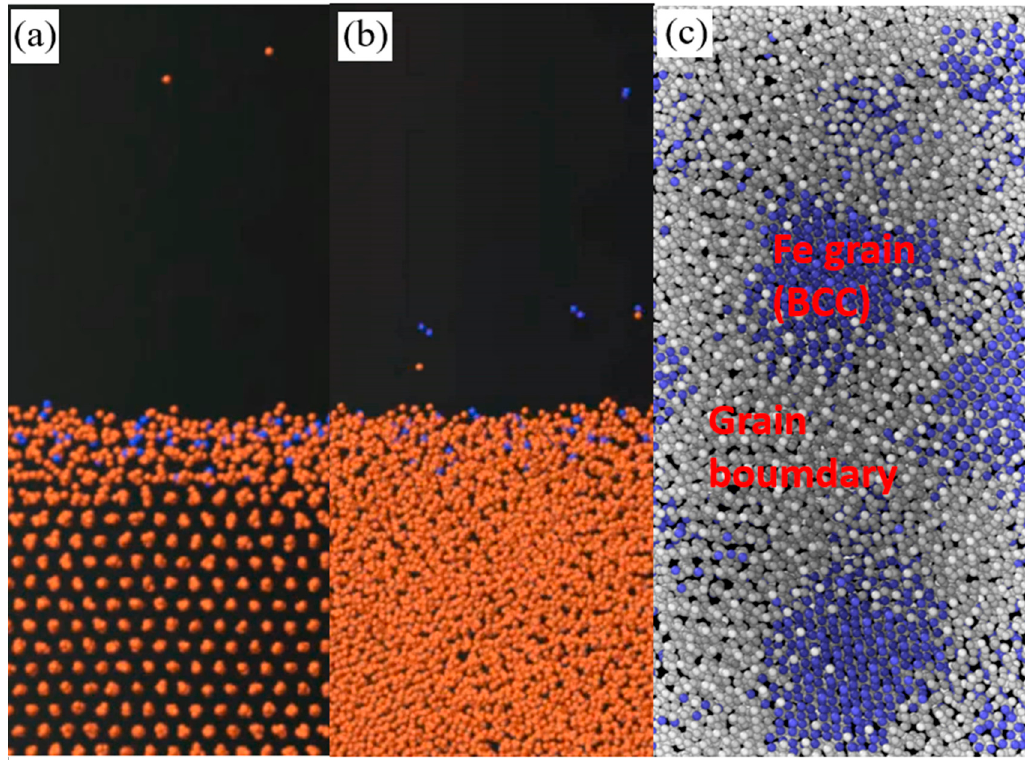
Figure 9. Stacking structure of Fe atoms treated with N plasma: ( a ) single-crystal Fe treated at 10 eV, ( b ) polycrystalline Fe treated at 10 eV, ( c ) grain boundary of polycrystalline Fe treated at 10 eV. Materials 2020 , 13 , x FOR PEER REVIEW 10 of 14